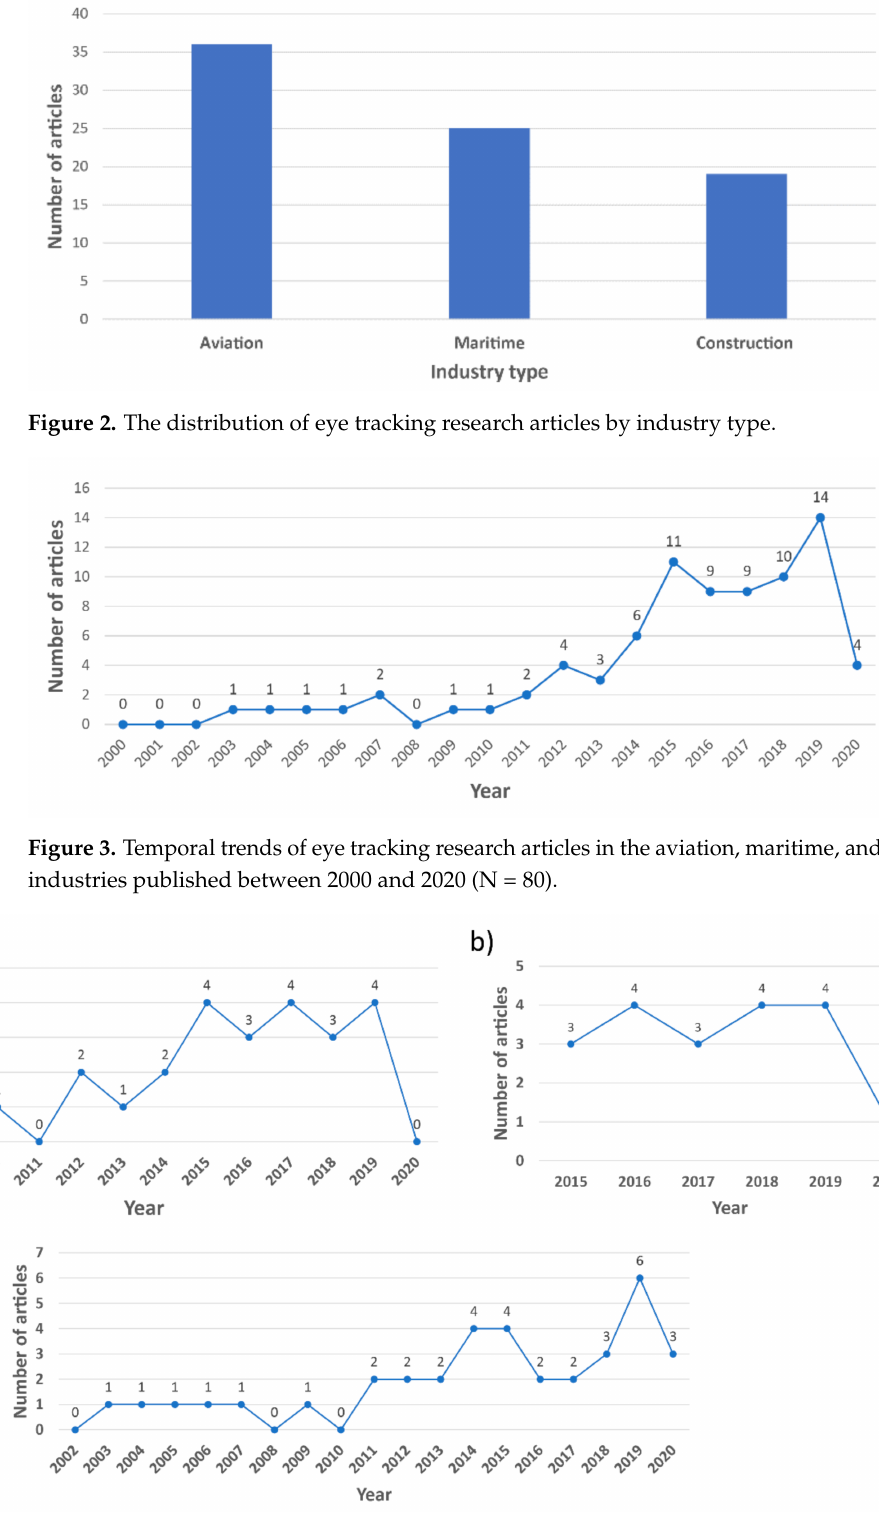
Figure 4. Temporal trends of the number of eye tracking research articles per year in the ( a ) maritime industry (N = 25), ( b ) construction industry (N = 19), and ( c ) aviation industry (N =